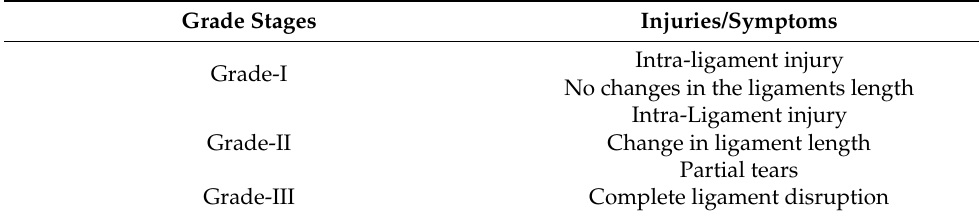
Table 1. Three grade stages of the anterior cruciate ligament. Grade